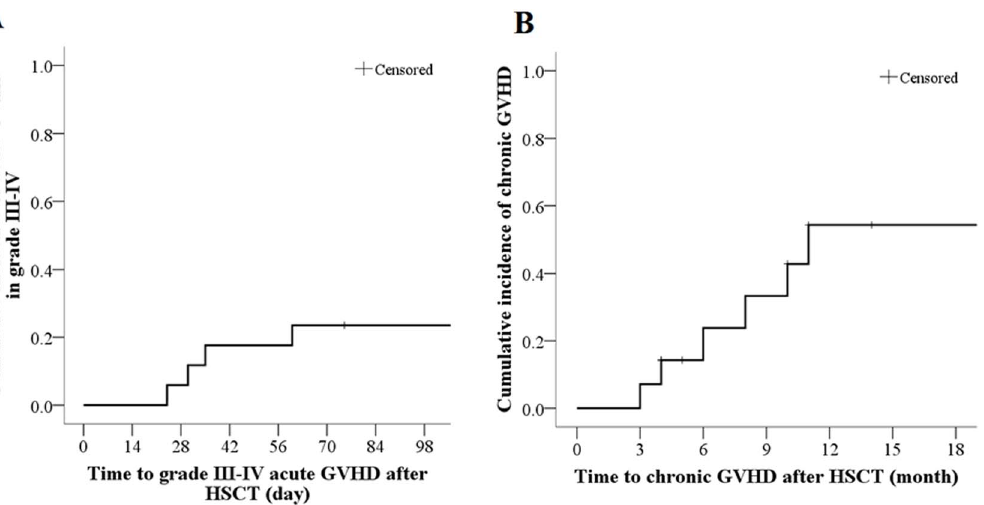
Figure 2. The Kaplan-Meier curve for the cumulative incidences of grade III–IV acute GVHD (A) and chronic GVHD (B).